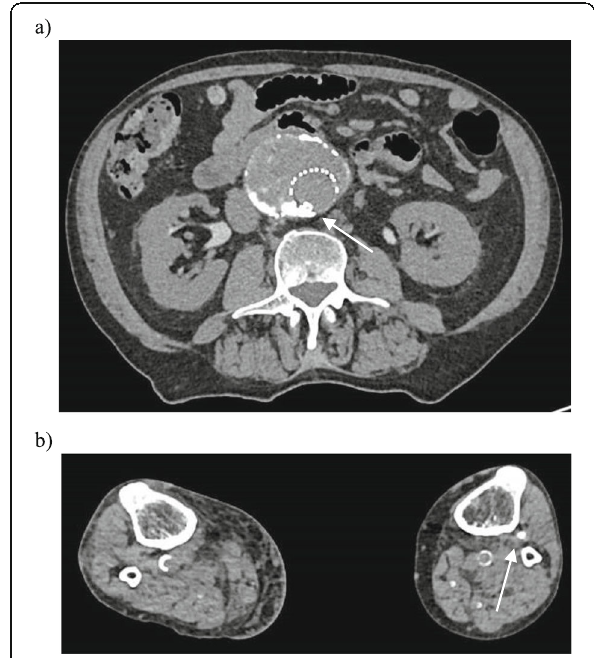
limbs performed 1 h after embolisation. Note: contrast excretion is seen from the kidneys due to contrast administered at the time of the angiography procedure. a Non-target embolisation of glue is seen (white arrow) in the stent graft lumen (arrow). b Axial non- contrast CT at the level of the calf demonstrates